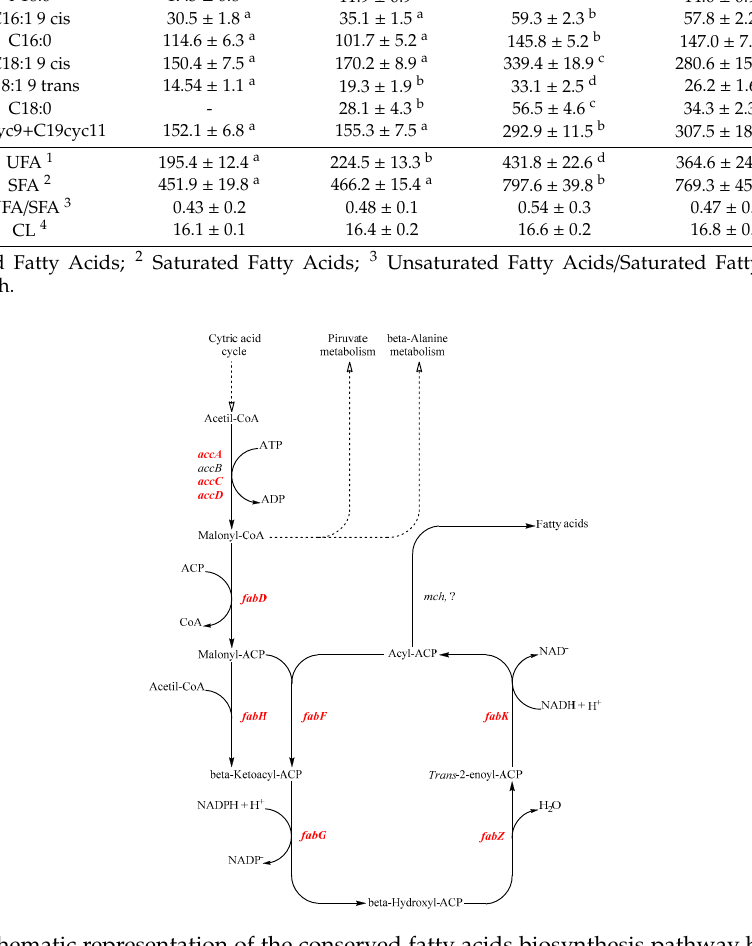
Figure 1. Schematic representation of the conserved fatty acids biosynthesis pathway based on the Lb. paracasei ATCC334 fatty acids synthesis model. In red are highlighted the genes considered in this study. Acc genes ( accA , accB , accC , accD ) are involved in the malonyl-CoA synthesis. Malonyl-ACP Malonyl-CoA:ACP transacylase ( fabD ) catalyze the coenzyme A substitution with an acyl carrier protein (ACP). Malonyl-ACP is condensed by 3-oxoacyl-ACP synthase ( fabH ) to acetyl-CoA, producing a β -ketoacyl-ACP. Ketoacyl-ACP reductase ( fabG ) starts with a reduction and is followed by a dehydration executed by 3-hydroxyacyl-ACP- dehydratase ( fabZ ). A second reduction by enoyl-ACP-reductase ( fabK ) produces acyl-ACP. In order to continue the elongation reaction, acyl-ACPs are dehydrated by 3-oxoacyl-ACP synthase ( fabF ) and the elongation chain cycle starts again. Once su ffi ciently elongated, acyl-ACPs are processed by di ff erent hydrolytic enzymes depending on the chain length. Medium-chain fatty acids (i.e., C:12) are released by the esterase activity of the Medium-chain acyl-ACP hydrolase ( mch